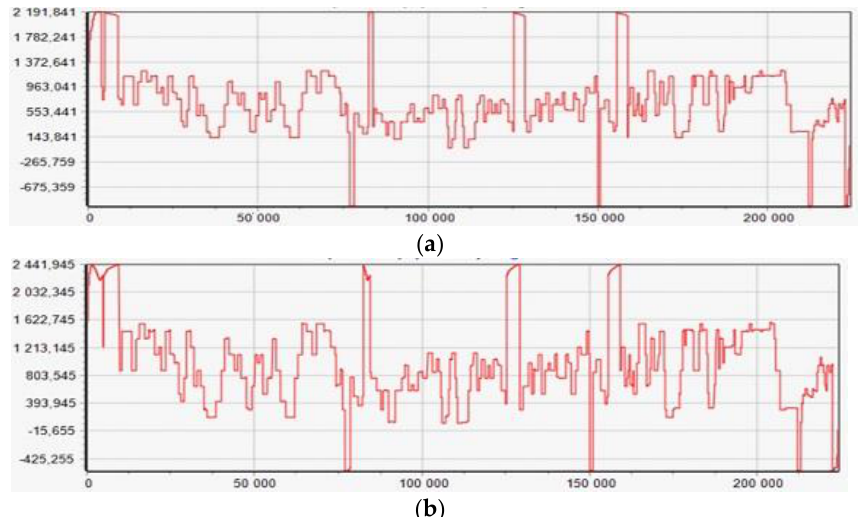
Figure 12. Current drawn by trains on the route TII-direction GM-Z ( a ) ED250 and ( b ) PAS. Source: developed by the authors-simulation results.